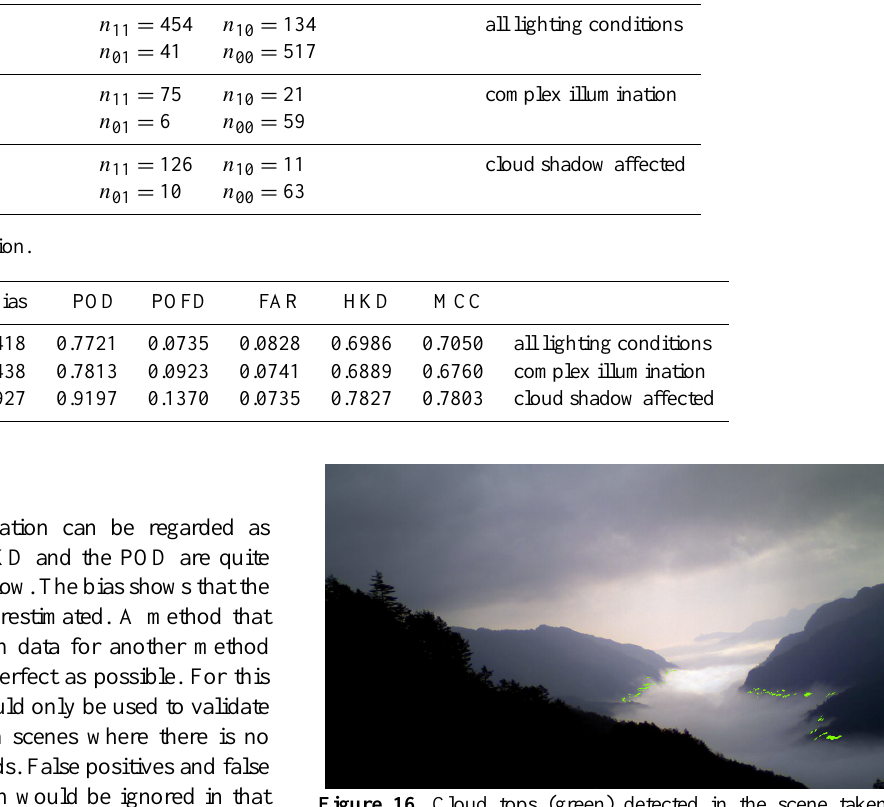
all lighting conditions